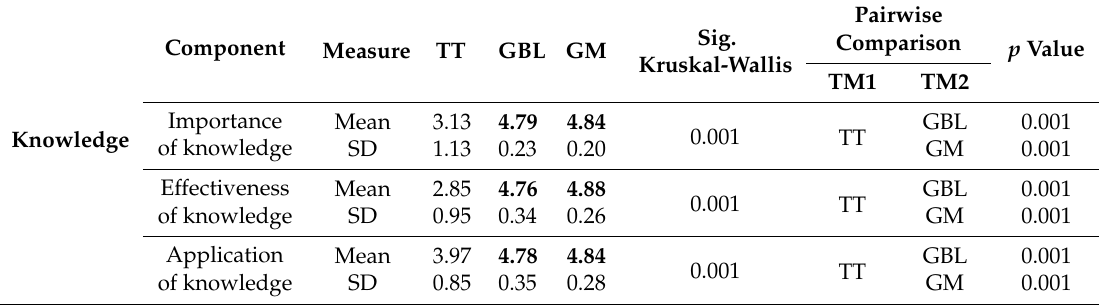
Table 5. Descriptive statistics (with means of the experimental groups in bold) and pairwise comparison of teaching methods for the Knowledge